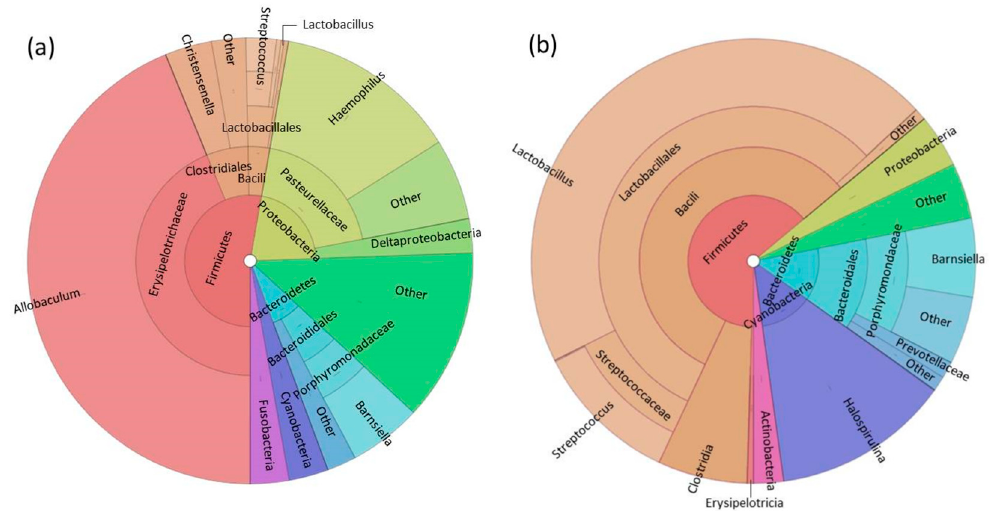
Figure 5. Cladogram-style pie charts (Krona charts) showing the average relative abundance of taxa in ( a ) colony and ( b ) wild foregut samples. All ‘other’ categories in each chart encompass taxa present at <1% abundance.